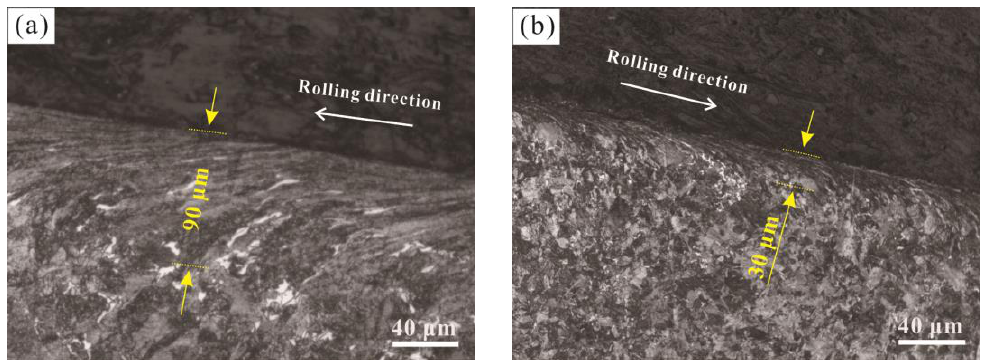
Figure 13. Optical microscope (OM) micrographs of plastic deformation in wear scar section for the